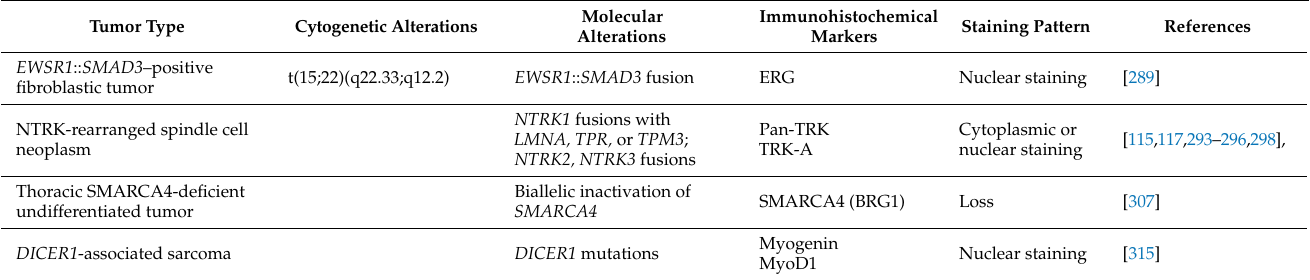
Table 3. Molecular genetic alterations and immunohistochemical markers in emerging